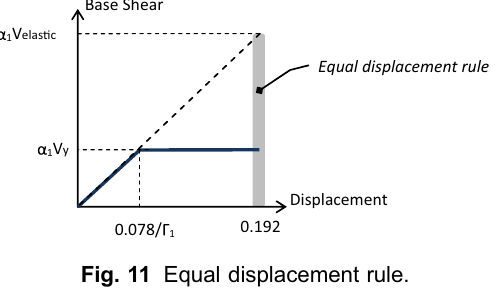
Fig. 11 Equal displacement